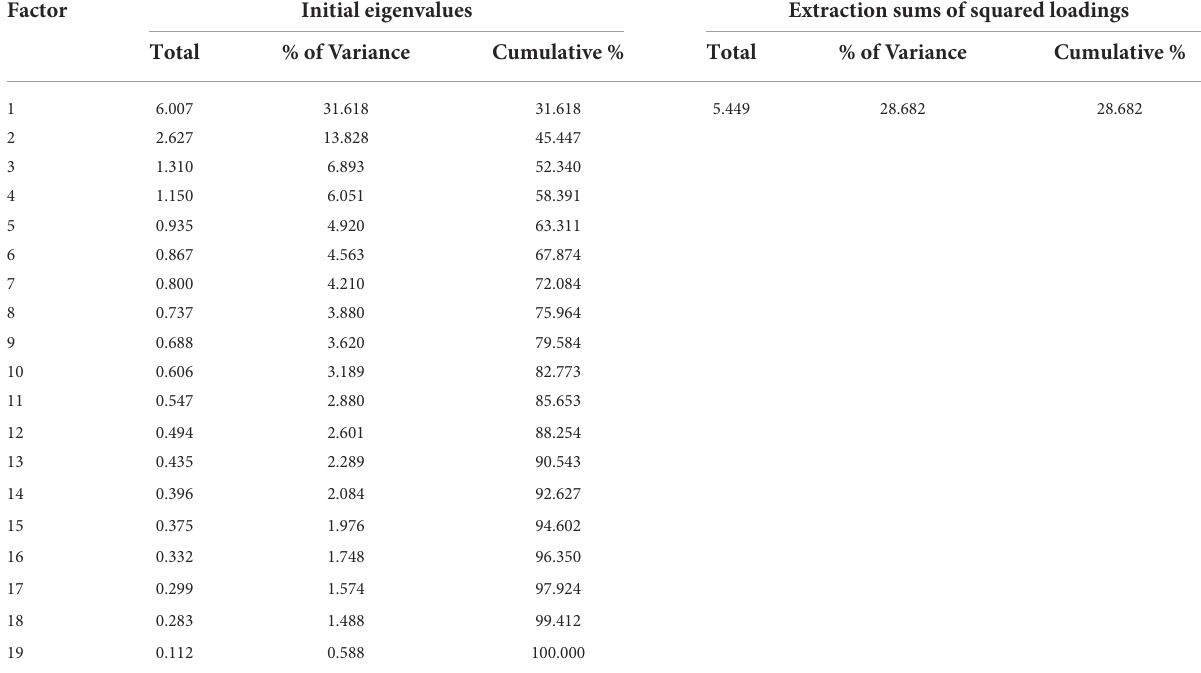
TABLE 1 Common method variance.